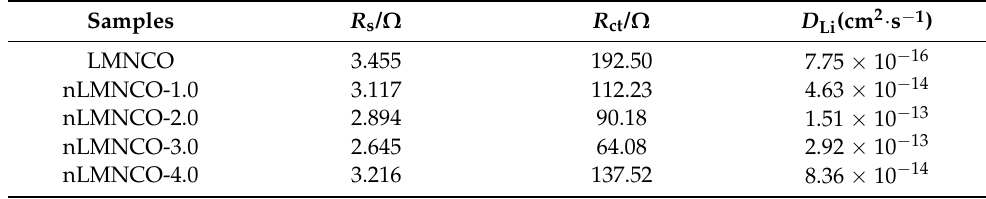
Table 4. Impedance parameter and diffusion coefficients of cathode